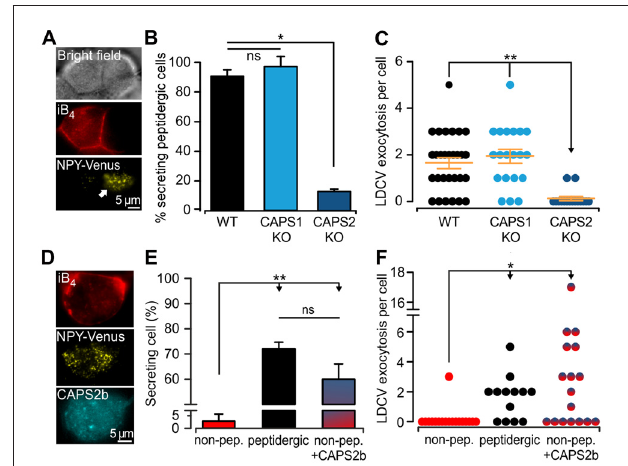
FIGURE 4 | CAPS2 is the priming factor of LDCVs in DRG neurons. (A) Exemplary images of CAPS1 KO DRG neurons. The two cells visible in the bright field image (top) are either non-peptidergic (stained red with iB 4 -Alexa561, middle left) or peptidergic (middle right). LDCV exocytosis was measured in the NPY-Venus transfected peptidergic neuron (white arrow, total internal reflection fluorescence microscopy image, bottom). The stimulation protocol was the same as that in Figure 2 . (B) Percentage of peptidergic neurons that secreted LDCVs depending on their genotype; which were WT, CAPS1 KO and CAPS2-deficient (CAPS2 KO). The number of preparations (i.e., mice) was 7, 7, and 4 for WT, CAPS1 KO and CAPS2 KO, respectively (ANOVA on ranks Holm-Sidak method: ∗ p < 0.05). (C) Scatter dot plots of total LDCV exocytosis in the CAPS1 KO and CAPS2 KO peptidergic neurons in comparison to their respective WT controls. Orange dashes are the average LDCV exocytosis ± SEM (N mice = 7, 7, and 4, n neurons = 32, 20 and 16 for WT, CAPS1 KO, and CAPS2 KO, respectively; ANOVA on ranks Kruskal-Wallis test: ∗∗ p < 0.01). (D) Representative image of a WT non-peptidergic DRG neuron co-transfected with NPY-Venus and CAPS2-mTFP. The neuron was identified by triple staining in red for iB 4 -Alexa568 (top), yellow for NPY-Venus (middle), and cyan for CAPS2-mTFP (bottom). LDCV exocytosis induced